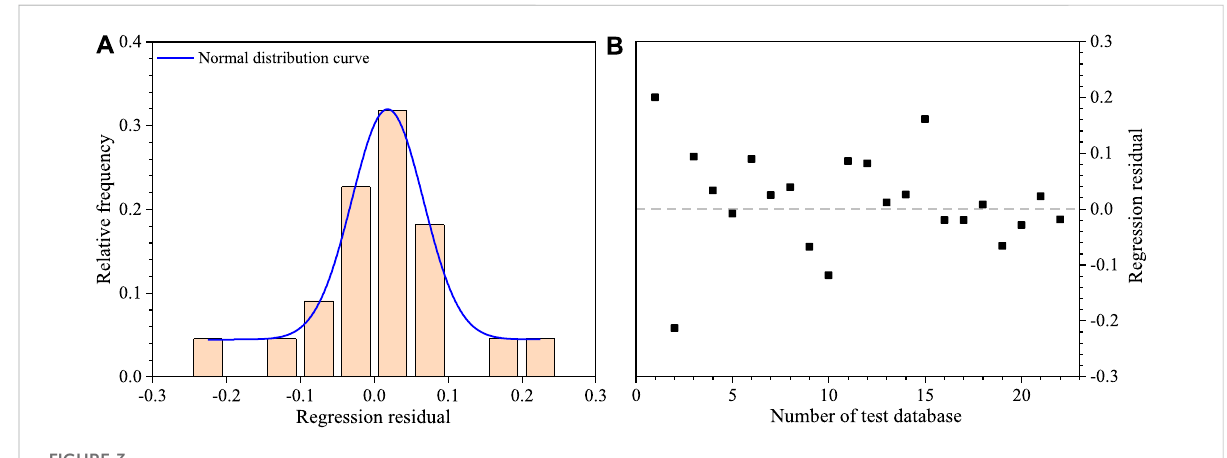
FIGURE 3 The regressionanalysis results of Eq. 7-2 based on thetest database of 22 channelizedrock avalanches: (A) Histogram of therelativefrequency of the log(H/L) regression residuals. (B) Plot of regression residuals of log(H/L).